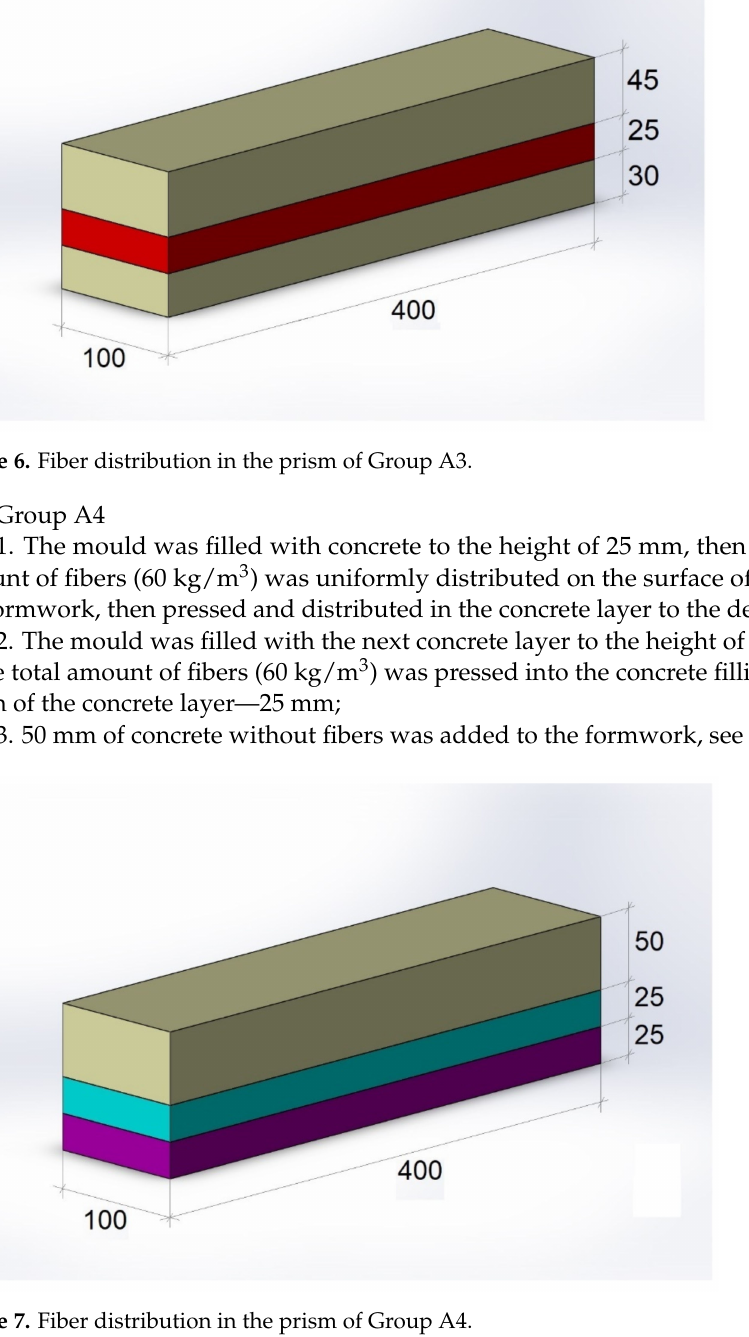
Figure 7. Fiber distribution in the prism of Group